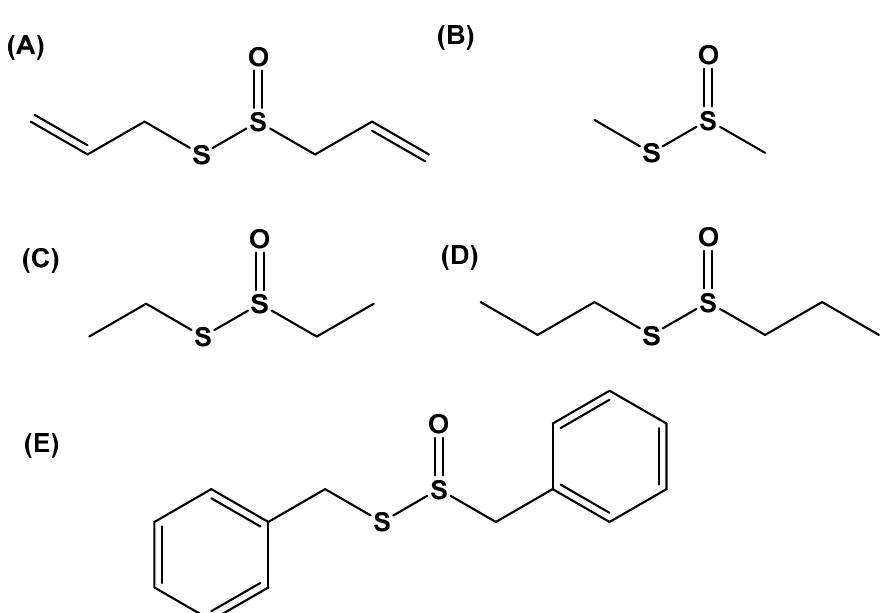
Figure 2. Structures of novel antimicrobial and antifungal thiosulfinate derivatives of ( A ) allicin, ( B ) dimethylthiosulfinate, ( C ) diethylthiosulfinate, ( D ) dipropylthiosulfinate, and ( E ) dibenzylthiosulfinate (adapted from [61]) .